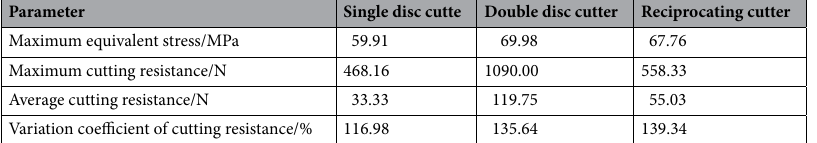
Table 1. Simulation